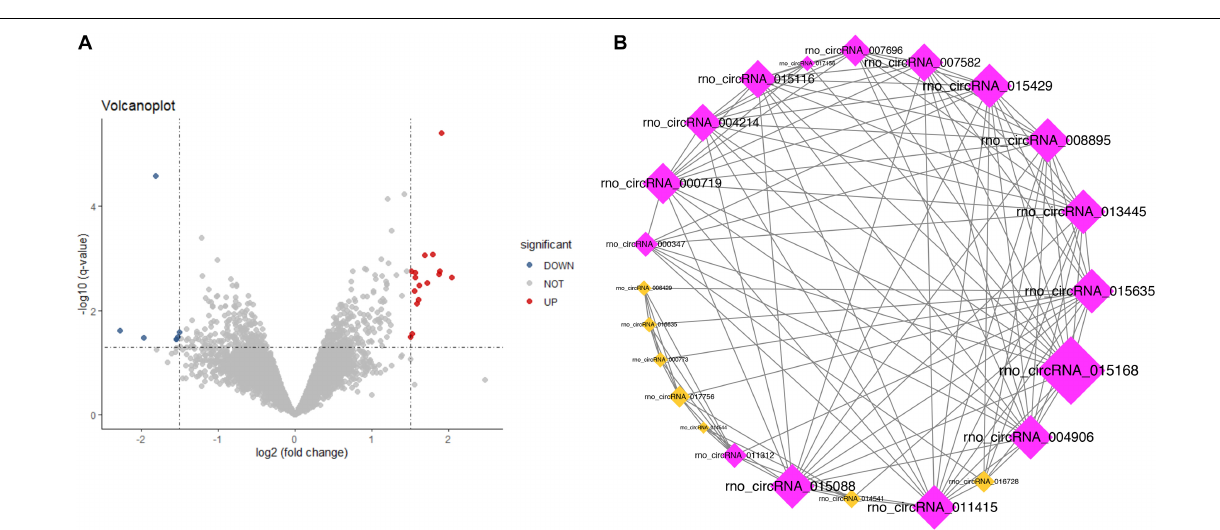
FIGURE 6 | Volcano plot (A) and coexpression network (B) of the differentially expressed circRNAs ( P < 0.05 and | log 2 FC| ≥ 1.5): red for upregulation and blue for